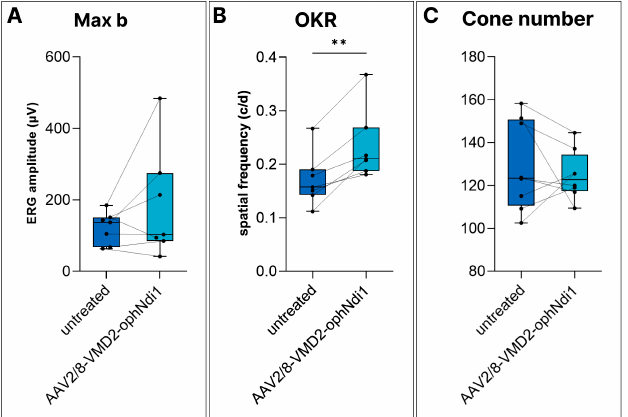
Figure 4. AAV2/8-VMD2-ophNdi1-mediated benefit in the NaIO 3 -induced murine model of AMD. ( A , B ) Adult 129 S2/SvHsd mice were subretinally injected with 4.5 × 10 8 vg AAV2/8-VMD2-ophNdi1 and 1.0 × 10 8 vg AAV2/2-CAG-EGFP in one eye, while contralateral eyes received an equal volume of PBS containing 1.0 × 10 8 vg AAV2/2-CAG-EGFP ( n = 7). At 3 months post-injection 22 mg/kg NaIO 3 in 0.9% NaCl 2 was administered via tail vein. ( A ) One week post-insult, ERG analysis was undertaken. ( B ) OKR analysis four weeks post-insult. ( C ) Additional adult 129 S2/SvHsd mice were injected with 4.5 × 10 8 vg AAV2/8-VMD2-ophNdi1 and 1.0 × 10 8 vg AAV2/2-CAG-EGFP in one eye, while contralateral eyes received an equal volume of PBS containing 1.0 × 10 8 vg AAV2/2-CAG-EGFP ( n = 7). Three months post-injection 50 mg/kg NaIO 3 in 0.9% NaCl 2 was administered via tail vein. Seven days post-insult mice were sacrificed, eyes fixed, retinas cryosectioned and stained with Arr3 immunocytochemistry (cone antibody, magenta) and DAPI (nuclear stain, dark blue). ** p < 0.01; paired t